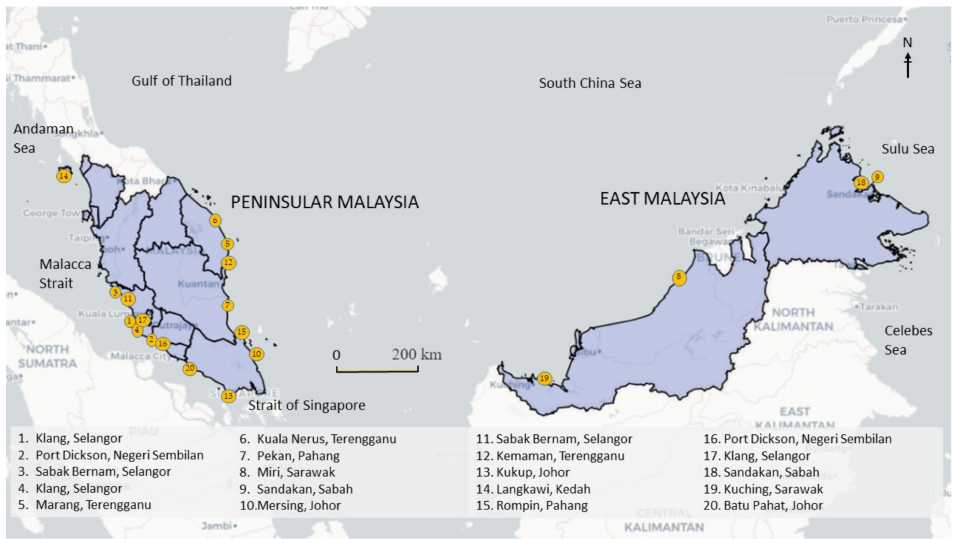
Figure 1. Study areas along the shoreline of Peninsular (PM) and East Malaysia